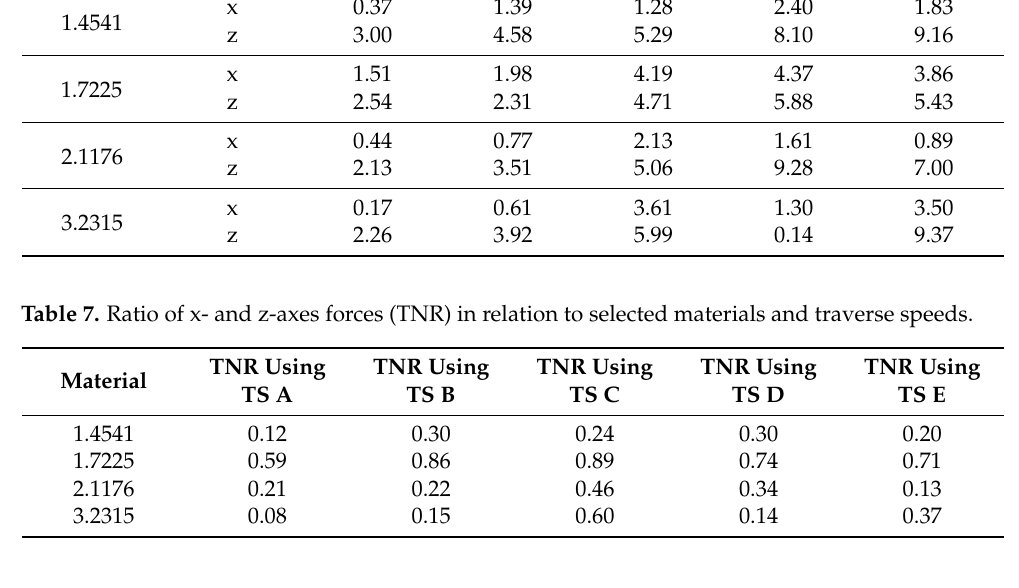
Table 6. Forces in the x- and z-axes in relation to the selected materials and the traverse speeds. Force for Material Axis